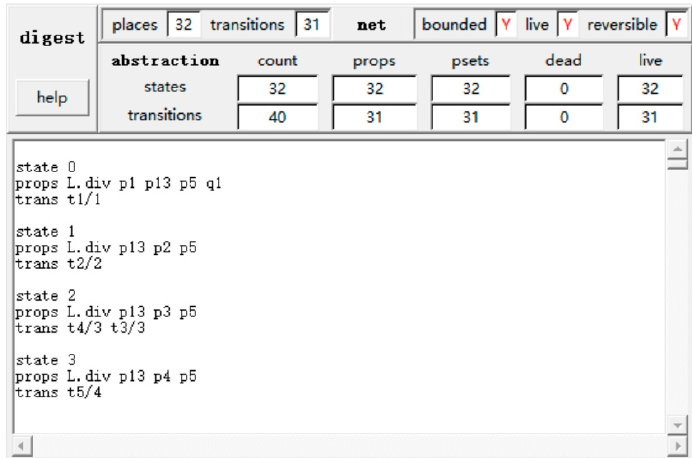
Figure 8. The original smart restaurant model Σ = { N , F , G , M } in Tina.